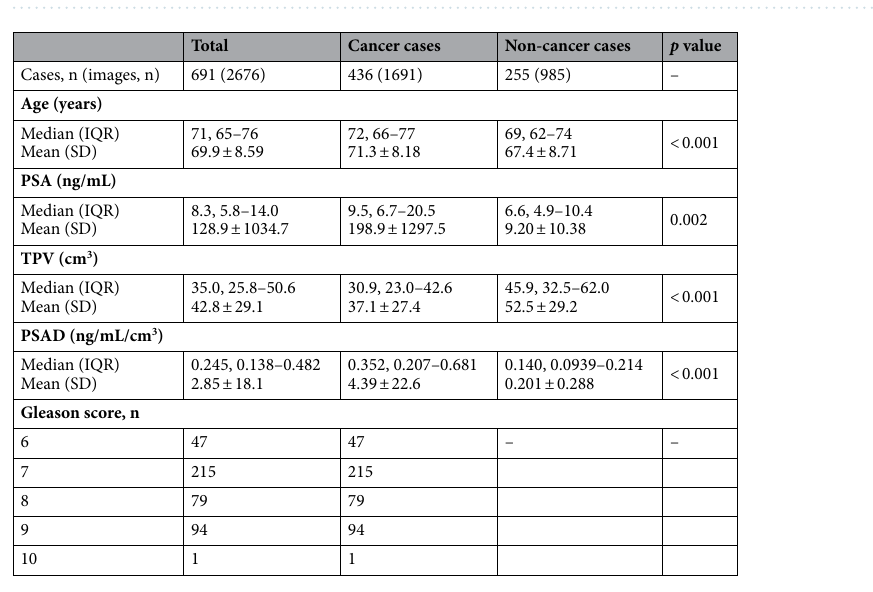
Table 1. Patient characteristics. PSA prostate-specific antigen, TPV total prostate volume, PSAD PSA density, IQR interquartile range, n number, SD standard deviation.